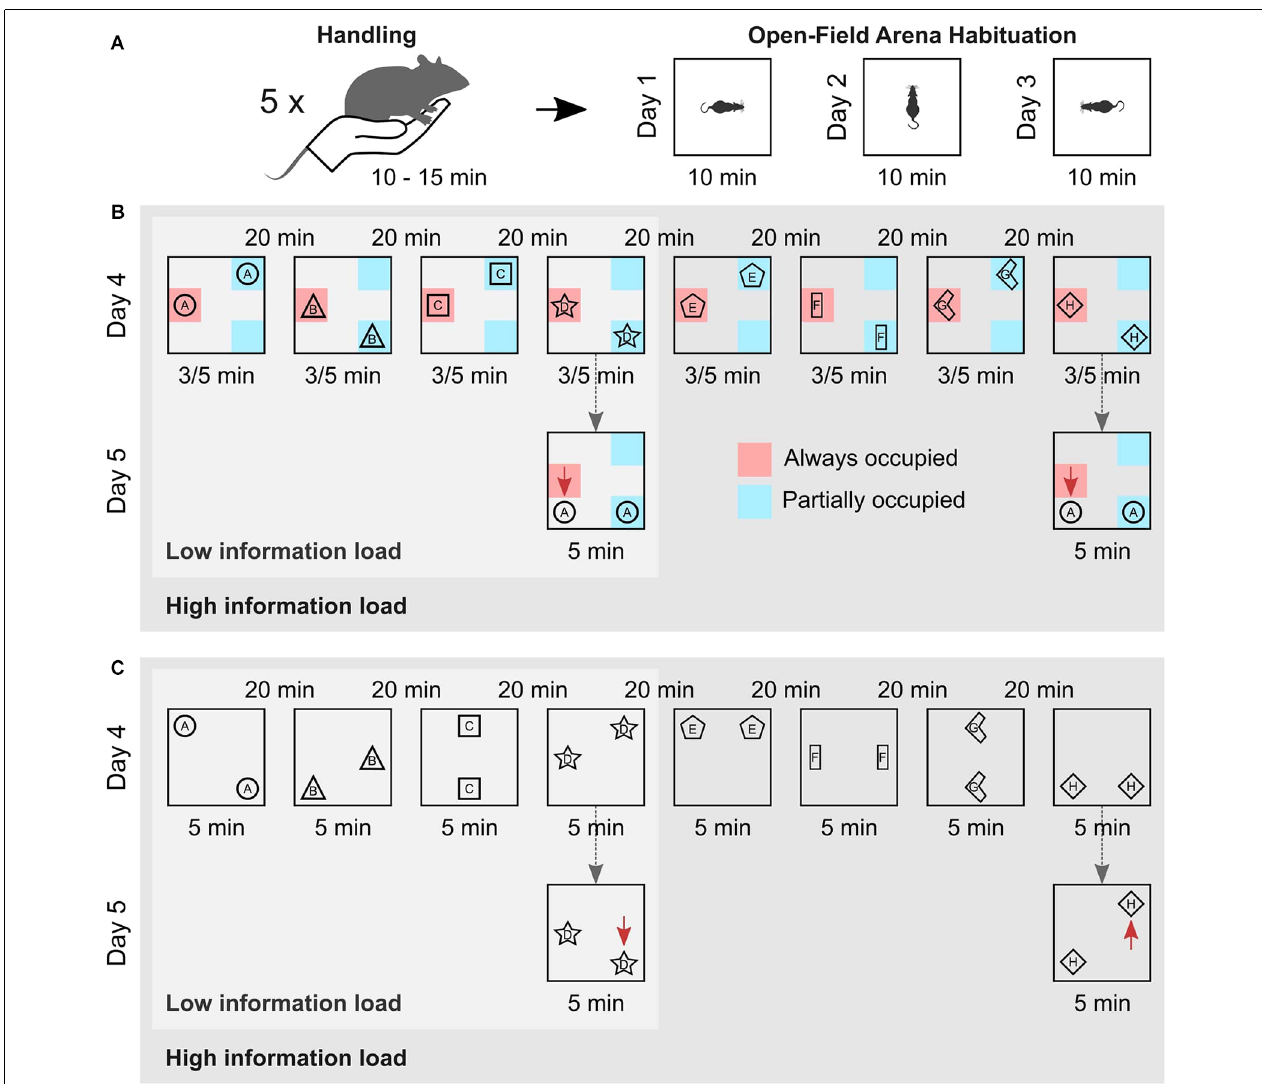
FIGURE 1 | Experimental procedure. (A) Animals were handled on five consecutive days for 10–15 min prior to the experiment (left). Then, they were habituated to the empty arena for 10 min on three consecutive days. They entered the arena facing different walls in each session to promote allocentric navigation (right). (B) Schema memory task. Animals either performed four (Low information load) or eight (High information load) encoding episodes, with an inter-trial interval of 20 min. In each episode, the rats explored different pairs of identical objects for 3/5 min, which were arranged according to a spatial rule across trials, i.e., one location was always (red zone) and two locations were only partially occupied (blue zones). Schema recognition memory (of the spatial rule) was tested 24 h later (dashed arrows). For this, objects from the first encoding episode were moved, so that both occupied locations different from encoding. The location of one object (red arrows) thus violated the spatial rule. Schema memory is assessed based on the increased exploration time the animal devotes to the object violating the spatial rule in comparison to the time spent exploring the other object. (C) Episodic memory task. Animals also performed on either four (Low information load) or eight